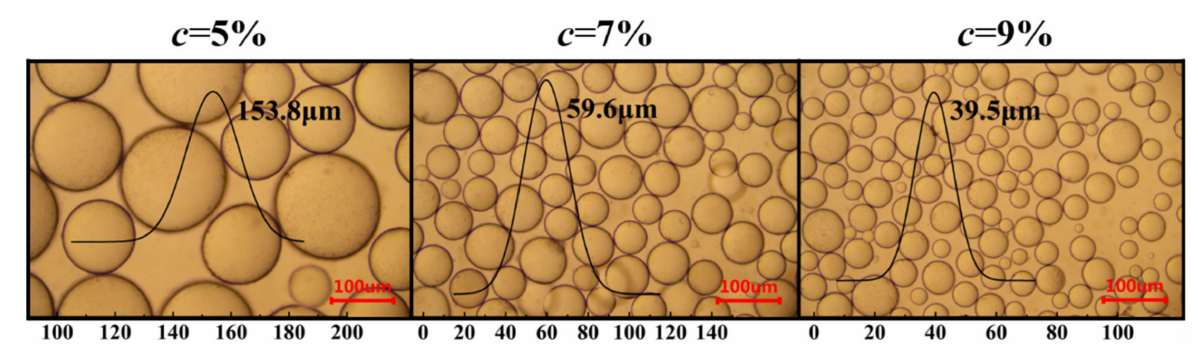
Figure 5. Microscopic observation of the Pickering emulsion gels developed by sorghum flour at mboxemph ϕ = 70% and c = 5, 7 and